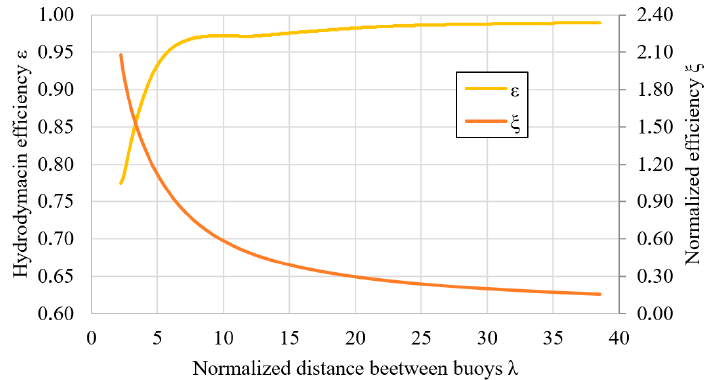
Figure 12. Hydrodynamic efficiency as function of normalized buoy distance.